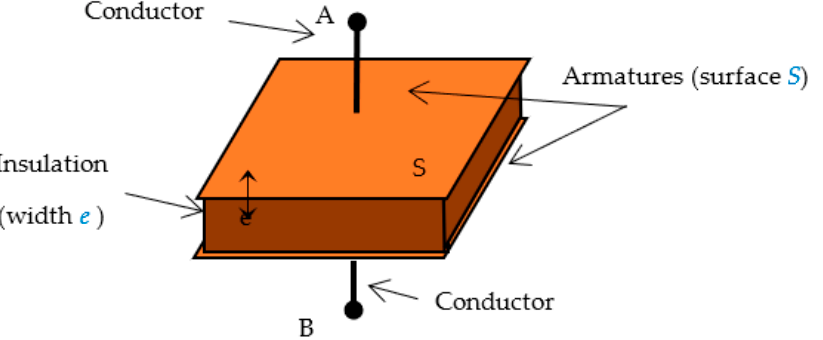
Figure 2. Representation of a planar capacitor.